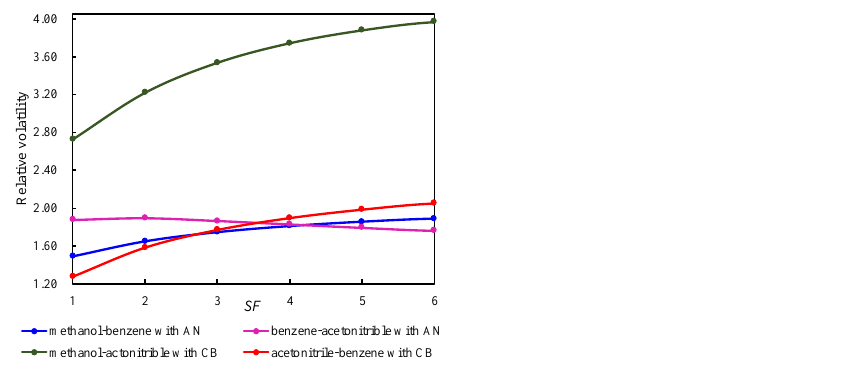
ration. For different solvents and SF s, the volatility order and the increment of relative